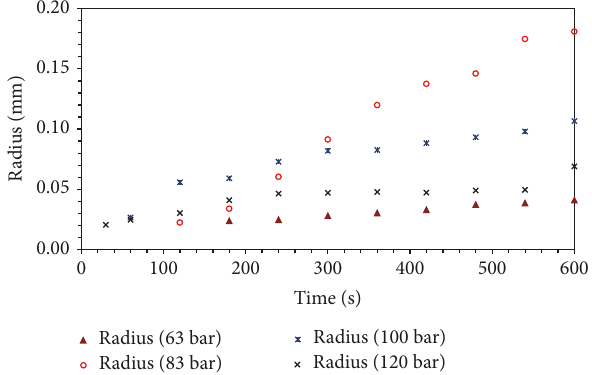
Figure 5: Bubble radius of PS/CO 2 during depressurization after holding at 63 to 120bar at 70 ∘ C for 2 hours.